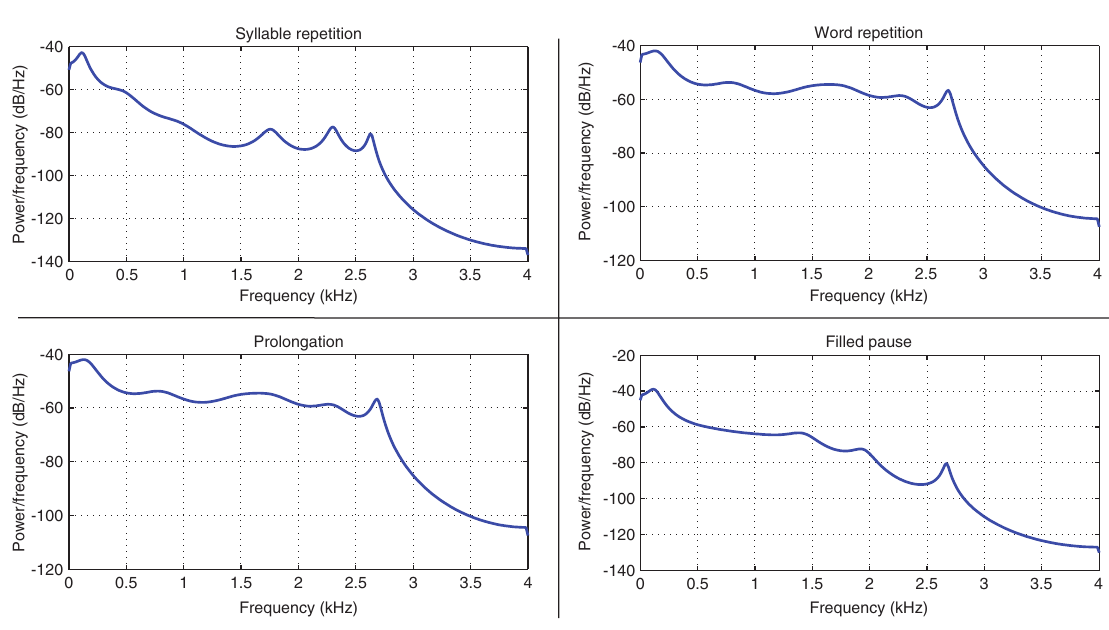
Figure 1: PSD Estimate of Four Different